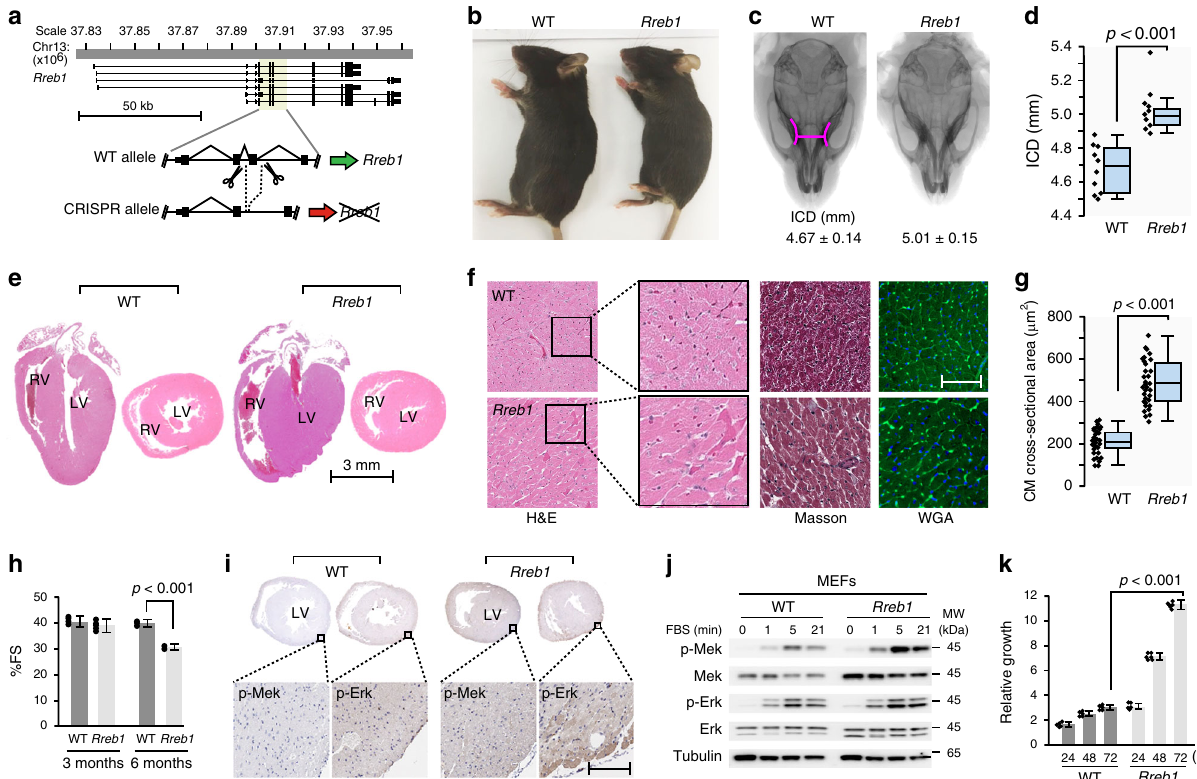
Fig. 2 Rreb1 haploinsuf fi ciency in mice resembles a Noonan-like RASopathy syndrome. a Genomic region around murine Rreb1 (UCSC Genome Browser, GRCm38/mm10 assembly). CRISPR-Cas9 guide sequences (scissors) fl anked an exon common to all splice variants. Cas9 editing results in a premature stop codon which disrupts the modi fi ed allele. b Gross appearance of male wild type (WT) and Rreb1 + / − ( Rreb1 ) mice. c Morphometric x-ray analysis of male WT and Rreb1 + / − skulls. Pink contour lines mark the edges of the eye sockets used for measurement of intercanthal distance (ICD). d Box plot analysis of ICD measurements taken from WT and Rreb1 + / − skulls ( n = 10). Box plots indicate the IQR of the data and the central line shows the median. p = 3.6E-05 two-tailed student ’ s t -test. e H&E staining of longitudinal and cross-sectional cardiac sections from 6 month WT and Rreb1 + / − hearts. Heart chambers labeled: LV, left ventricle; RV, right ventricle. Scale bar 3 millimeter (mm). Images are representative of n = 3 hearts examined. f H&E, Masson, and wheat germ agglutinin (WGA) staining of LV cardiac sections from 6 month WT and Rreb1 + / − hearts. Scale bar 100 μ m. n = 3 hearts examined. g Box plot analysis of cardiomyocyte (CM) cross-sectional area (12 CM measured per heart, n = 3 hearts). Quanti fi cation was performed using Aperio ImageScope software. Box plots indicate the IQR of the data and the central line shows the median, p = 5.6E-22 two-tailed student ’ s t -test. h Fractional shortening (FS%) determined by echocardiography on 3 and 6 month WT and Rreb1 + / − mice ( n = 10). Error bars presented as mean values ± SD, p = 6.6E-10 two-tailed student ’ s t -test. i IHC analysis of p-Mek and p-Erk in LV cardiac sections from WT and Rreb1 + / − hearts. Scale bar 100 μ m. n = 3 hearts examined. j Western blot analysis of MAPK signaling in WT and Rreb1 + / − MEFs following serum deprivation and stimulation with FBS for the indicated times. Tubulin served as a loading control. Blots are representative of n = 6 experiments. k Relative growth of WT and Rreb1 + / − MEFs in culture measured with Alomar Blue. Data average of n = 6 independent experiments, error bars presented as mean values± SD, p = 2.7E-15 two-tailed student ’ s t -test. Source data are provided as a Source Data fi